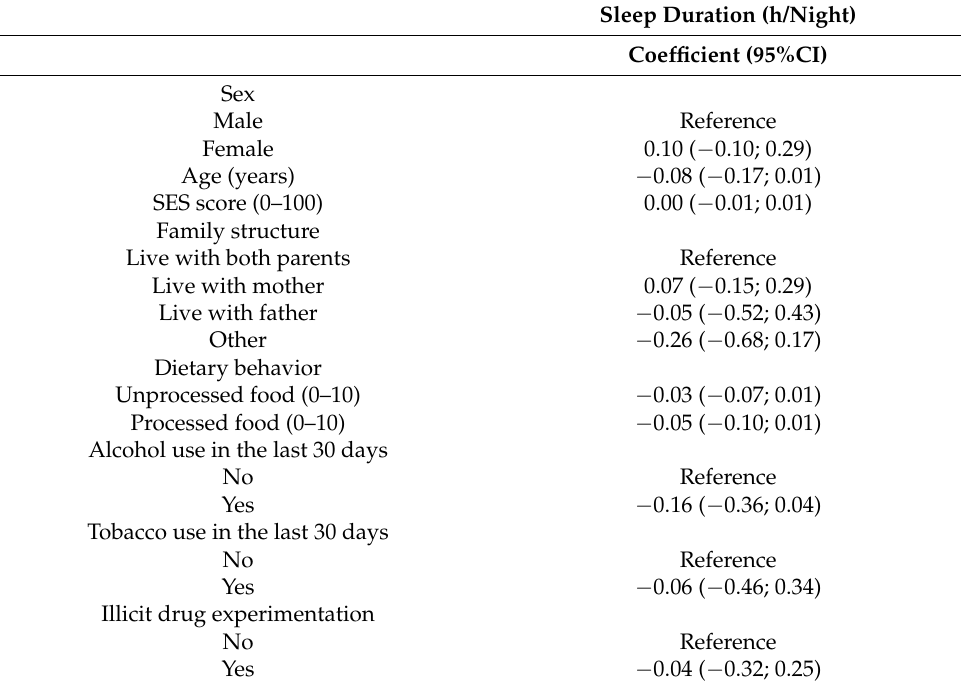
Table 4. Association between sociodemographic, dietary, and substance use factors with sleep duration in a sample of Brazilian adolescents ( n =